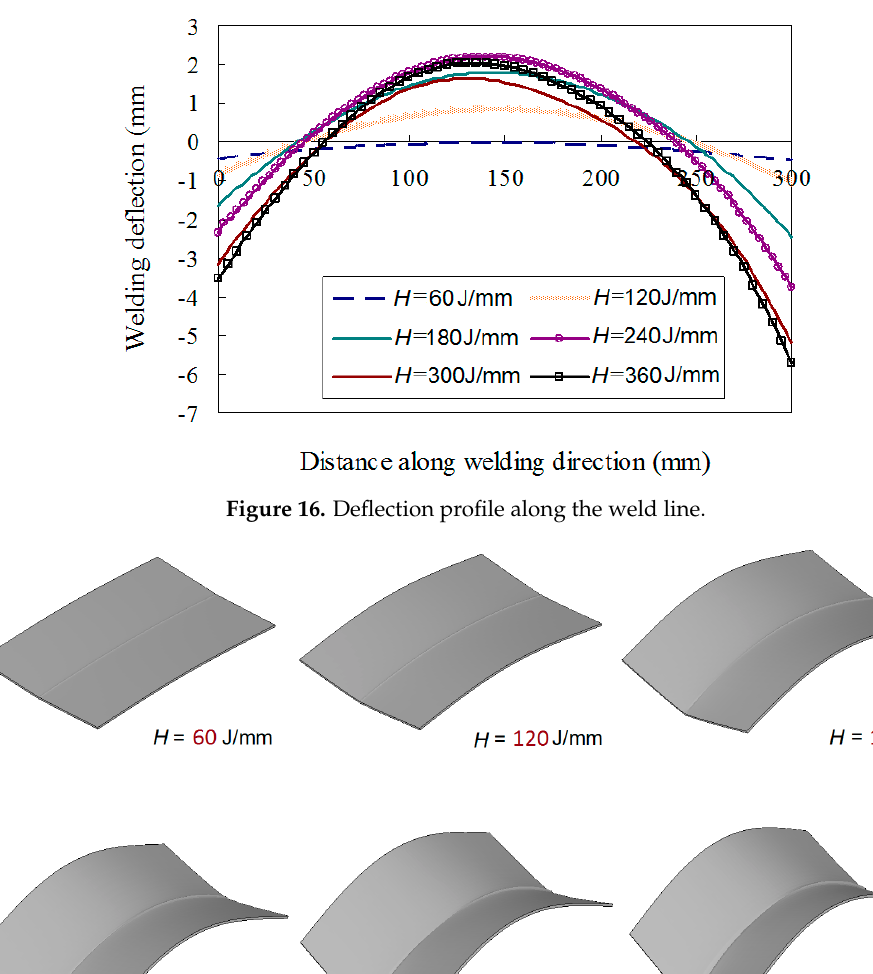
Figure 15. Relationship between welding heat input and maximum deflection.